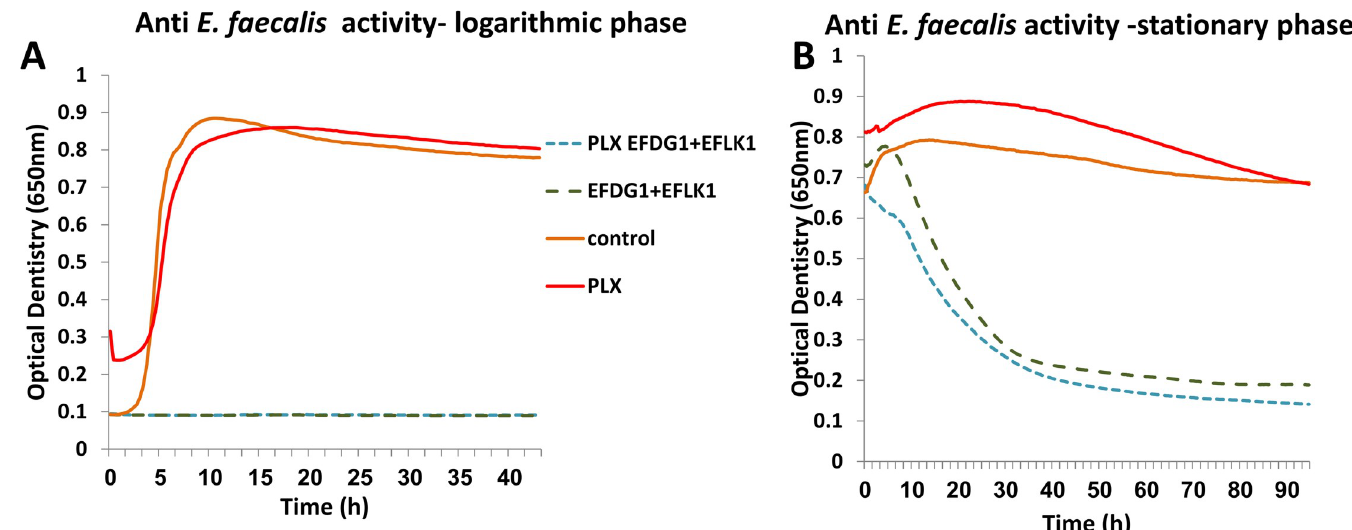
Fig 3. Poloxamer-phage formulation kills logarithmic and stationary E . faecalis . (A) Treatment of bacteria in the logarithmic growth phase with phages and poloxamer-phage formulation reduced bacterial growth. Treatment with phages and a poloxamer-phage formulation (dashed curves: EFDG1/EFLK1 phage cocktail) reduced bacterial growth of logarithmic E . faecalis compared with the control (untreated bacteria and poloxamer alone), as depicted by OD changes. The results are based on 6 independent biological replicates. (B) Treatment of E . faecalis in the stationary growth phase with phages and poloxamer-phage formulation reduced bacterial growth. Treatment with phages and a poloxamer-phage formulation (dashed curves: EFDG1/EFLK1 phage cocktail) reduced bacterial growth of stationary E . faecalis compared with that of cells in stationary phase treated with poloxamer alone (PBS based) and untreated bacterial control as depicted by OD changes. The results are based on 6 independent biological replicates.